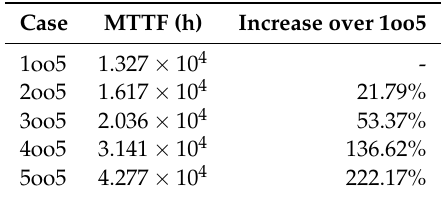
Table 4. MTTF evaluation for k-out-of-n fault